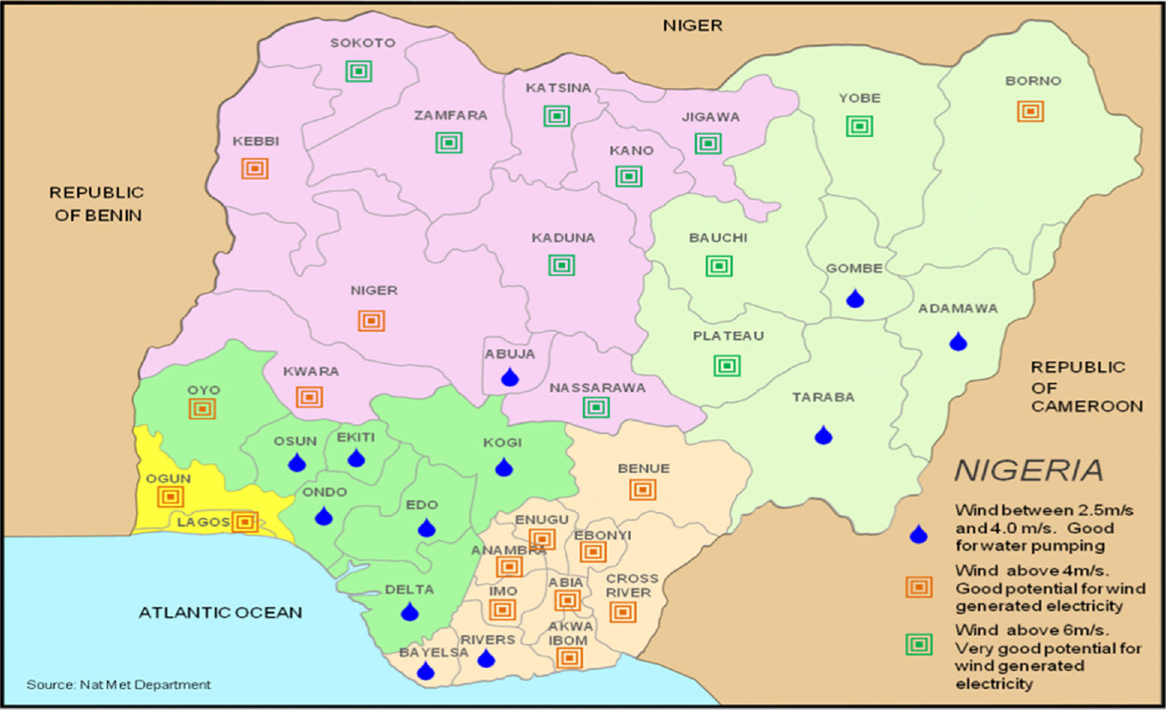
Fig. 1 Map of Nigeria Showing Geographic Allotment of Nigeria ’ s [11]